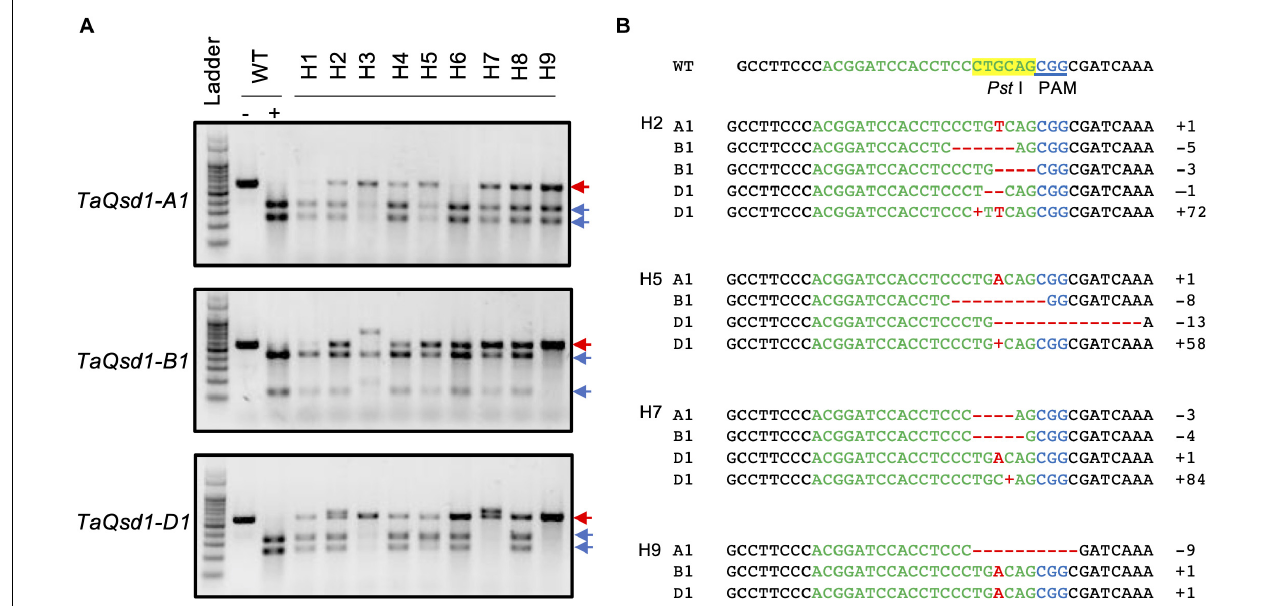
FIGURE 1 | Genotyping of the mutant alleles of the TaQsd1 locus in T0 plants. (A) Genomic DNA was isolated from the flag leaf of WT (cv. Haruyokoi) and the candidate T0 taqsd1 plants and then subjected to a cleaved amplified polymorphic sequences (CAPS) assay. The PCR products were amplified by A, B, and D genome specific primer sets. − , undigested PCR products; +, Pst I digested PCR products. Red and blue arrows indicate undigested and digested bands after Pst I treatment, respectively. A 100 bp ladder was used as a size marker. (B) The genotypes of H2, H5, H7, and H9 as identified by sequencing. The green and blue characters indicate the gRNA and PAM sequences, respectively. The Pst I restriction site is highlighted in yellow. Red “+” indicates insertion of the 72, 58, or 84 bp vector sequence in H2-D, H5-D, or H7-d, respectively ( Supplementary Figure 1 ) denotes the position of the long DNA fragment insertion. “+” indicates insertion of the 72, 58, and 84 bp of the vector sequence, respectively ( Supplementary Figure 1